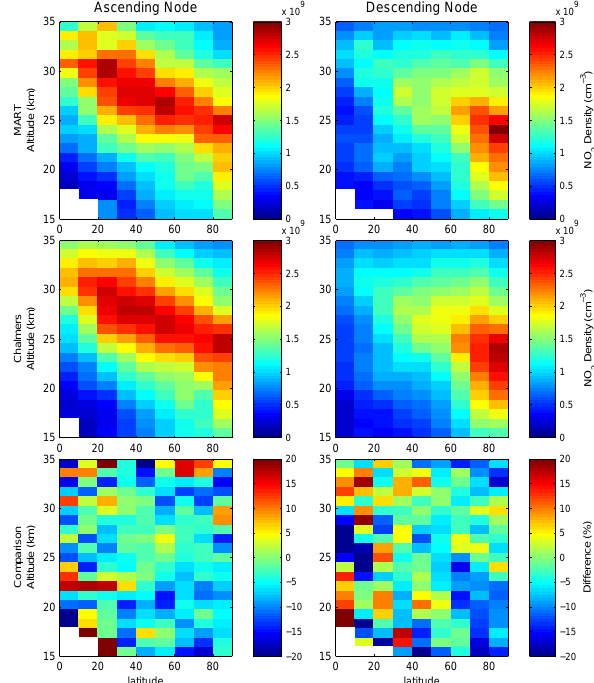
Fig. 4. A daily average of our retrievals (top) compared with the official OSIRIS version 3.0 retrievals (middle). The left column shows measurements made during the descending track of the Odin orbit, i.e. measurements at local morning twilight. The right column shows measurements from the ascending track of the orbit during local evening twilight. The bottom panels show the percent differ- ence between the two retrieved data sets.